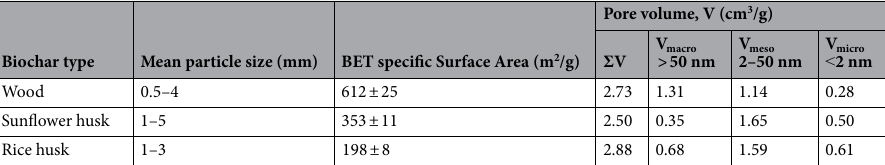
Table 2. Physical characteristics of the biochar